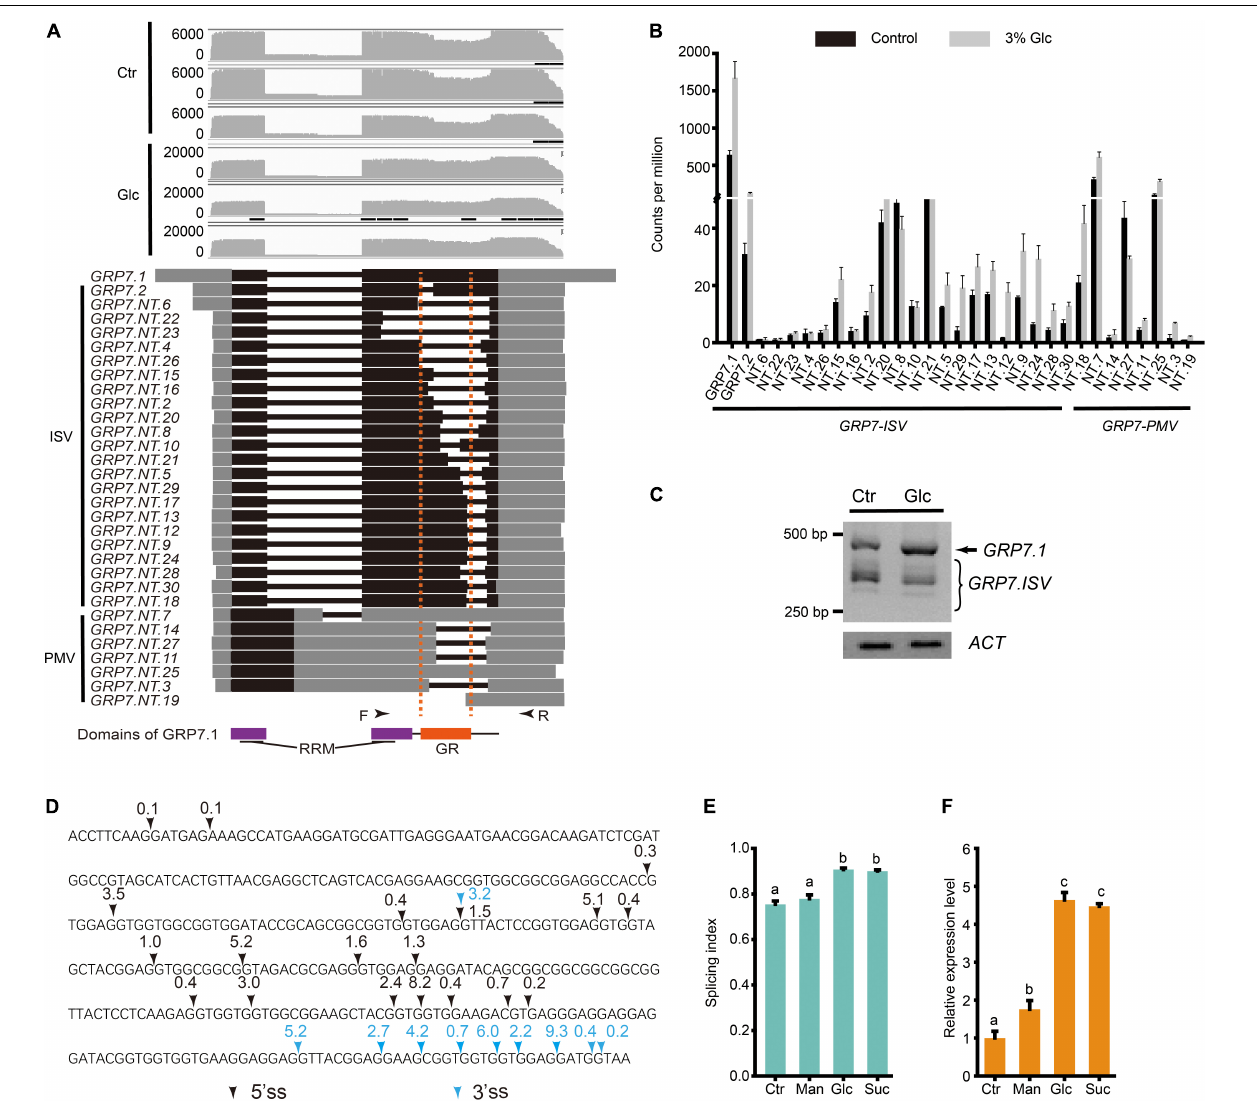
FIGURE 3 | Glucose stress regulates AS pattern change of GRP 7 in Arabidopsis seedling. (A) Gene model, AS isoforms, and IGV coverage diagrams of GRP7 . Black arrows represent the binding sites of the primers of RT-PCR in (C) . Dotted lines indicate the pre-mRNA regions coding for GR domain in GRP7. (B) Transcription level of GRP7 transcript variants by Nanopore sequencing. (C) RT-PCR result for GRP7 transcript variants. ACTIN ( ACT ) serves as the internal control. (D) The splicing sites of the cryptic intron in GRP7 pre-mRNA sequence. Black arrows represent the 5 (cid:48) splicing sites, and blue arrows represent the 3 (cid:48) splicing sites. The numbers above the arrows represents the percentage of the transcripts with the corresponding splicing site among total transcripts. (E) The SI of GRP7 transcripts upon control treatment and different high soluble sugar treatments, respectively. The SI of GRP7 was calculated by the ratio of GRP7.1 /( GRP7.1 + GRP7 using the fluorescence intensity of PCR products in RT-PCR). (F) The expression levels of GRP7 upon different treatments. Ctr, 0% glucose; Glc, 3% glucose; Man, 3% mannitol; Suc, 3% sucrose; ISV, intron spliced variant; PMV, pre-mature